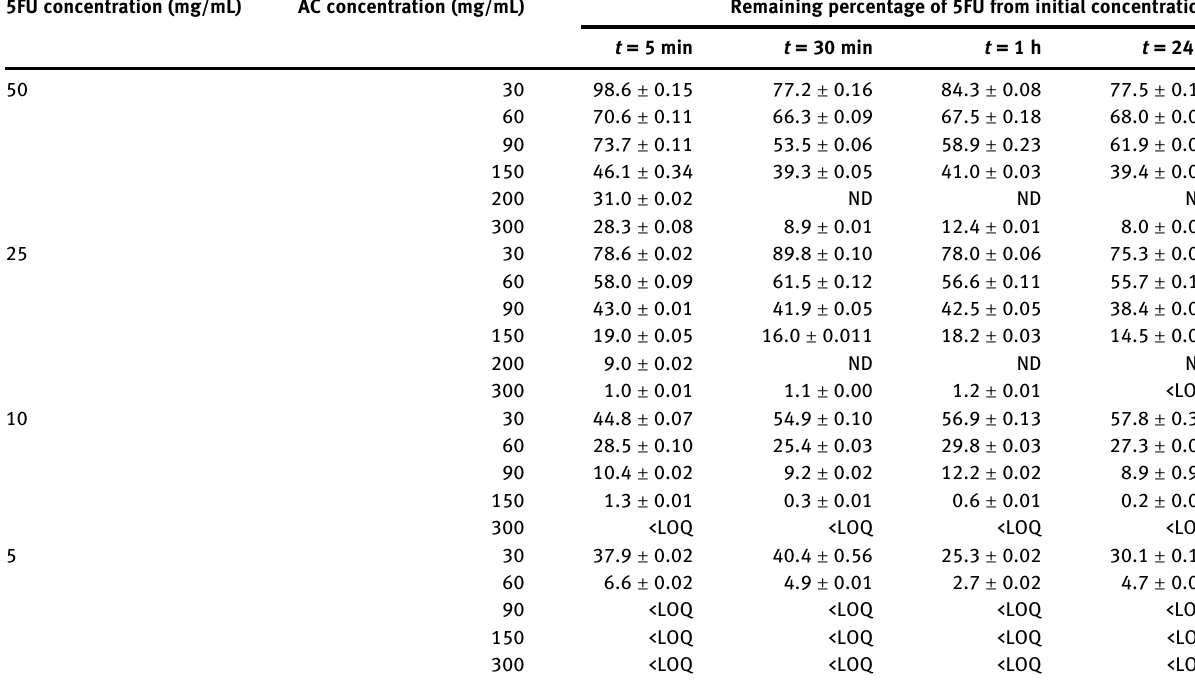
Table  : Contact time evaluation for complexation by activated carbon via vacuum fi ltration.  FU concentration (mg/mL)